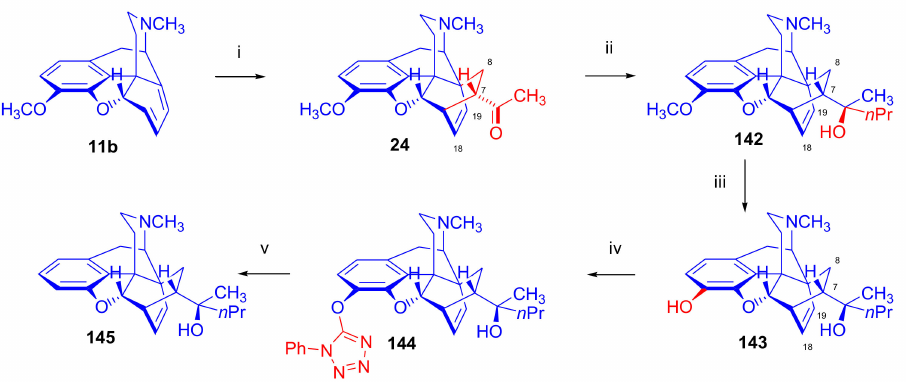
Figure 39. Synthesis of 6-demethoxy-3-deoxyetorphine from 6-demethoxythebaine. Reagents and conditions : (i): methyl vinyl ketone, reflux, (ii): n PrMgBr, (iii): KOH, diethylene glycol, 210 ◦ C, (iv): 5-chloro-1-phenyl-1 H -tetrazole, DMF, KO t Bu, nitrogen atmosphere, room temperature, 4 h, and (v):